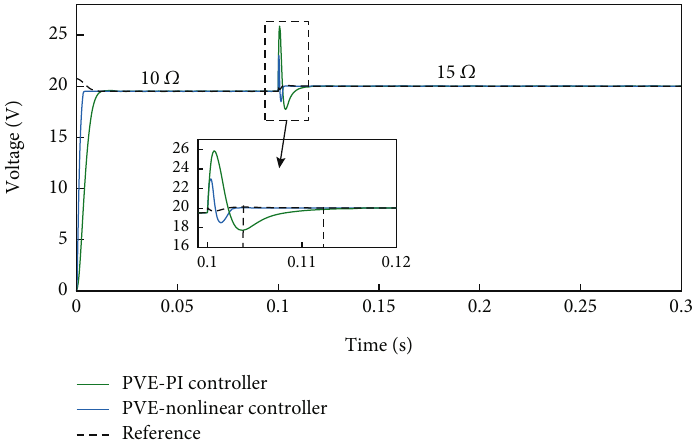
Figure 23: Dynamic performance comparison of the PVE-PI controller with the proposed PVE nonlinear controller under changing